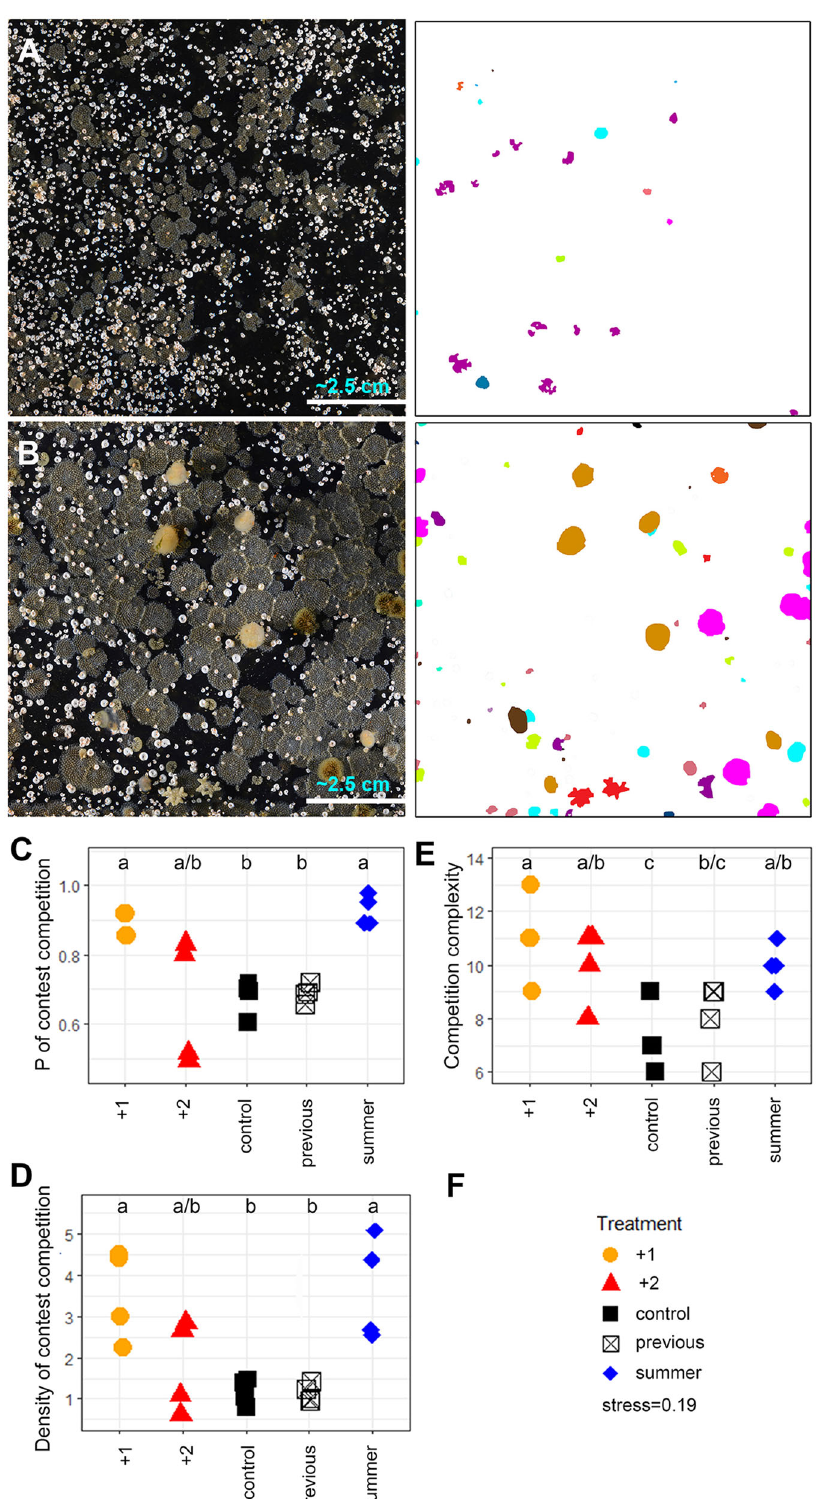
Fig. 2 Spatial competition on arti fi cial substrata at 15 m depth in Antarctica. Colonists of panels at ambient ( A ) and + 1 °C ( B ) treatments (9.8 ×9.8 cm), together with image analysis frames used to highlight less abundant species (right images). Rarer species are shown in different colours. Probability of individuals encountering competition ( C ), competition density ( D ) and complexity ( E ). Letters above plots C – E show signi fi cant differences between treatments. Degrees of freedom (DF) = 4, n = 20 for C – E ; ( C ) Welch ’ s one-way F = 28.326 p = 0.0001, Games – Howell post hoc tests p < 0.01; ( D ) Welch ’ s one-way F = 6.5527 p = 0.017, Games – Howell post hoc tests p < 0.1; ( E ) ANOVA F = 5.467 p = 0.006, Tukey HSD p < 0.1. Key to treatment symbols ( F ), + 1: warmed to + 1 °C; + 2: warmed to + 2 °C; controls: no warming; previous: deployed previously without warming; summer: warmer to